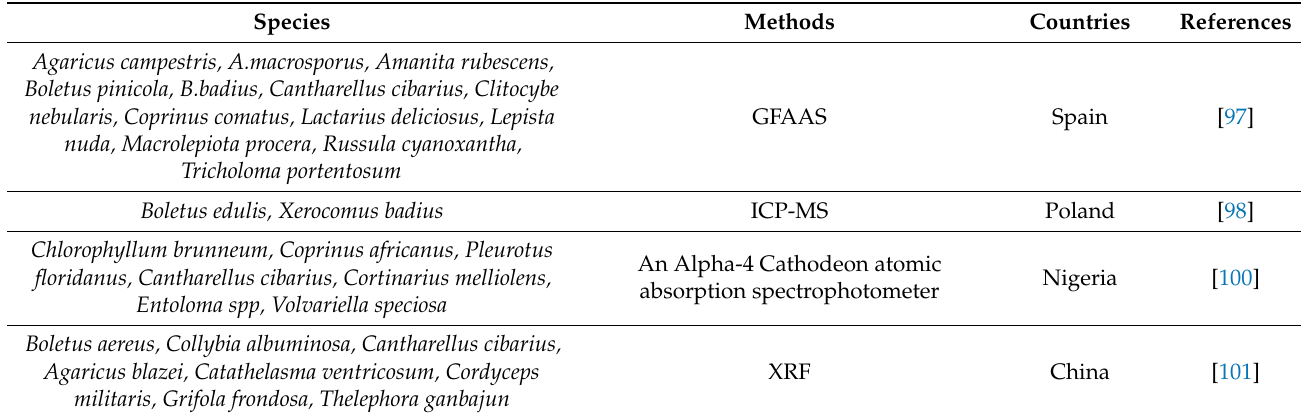
Table 7. Species, methods for determination of lead and countries in the